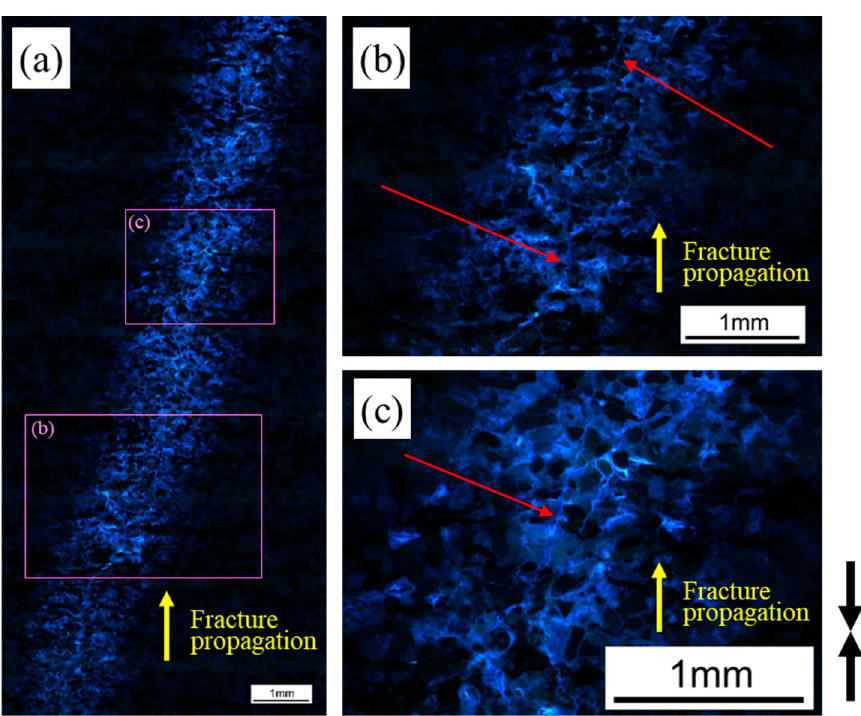
Figure 10. Resin-impregnated regions around the induced fractures observed in the Paleogene Kushiro shale specimen under UV light. ( a ) Overview of resin-impregnated region; ( b , c ) enlarged views of the parts indicated in figure ( a ). The pair of black arrows next to ( c ) represents the loading direction. The region is estimated to consist of networks of micropores within the shale matrix.